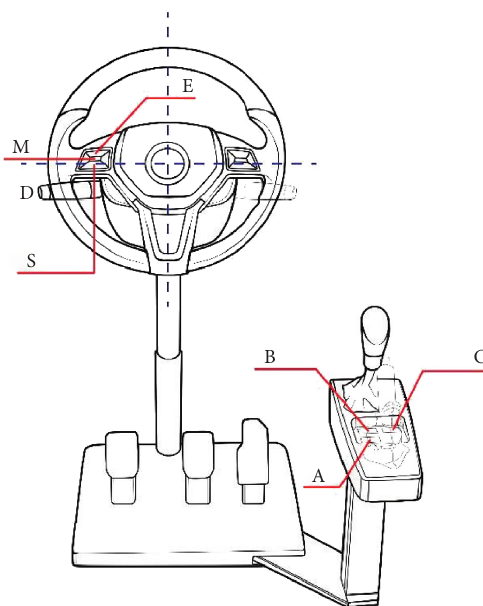
Figure 1: Wireframe of the driving simulator and the function keys used in the